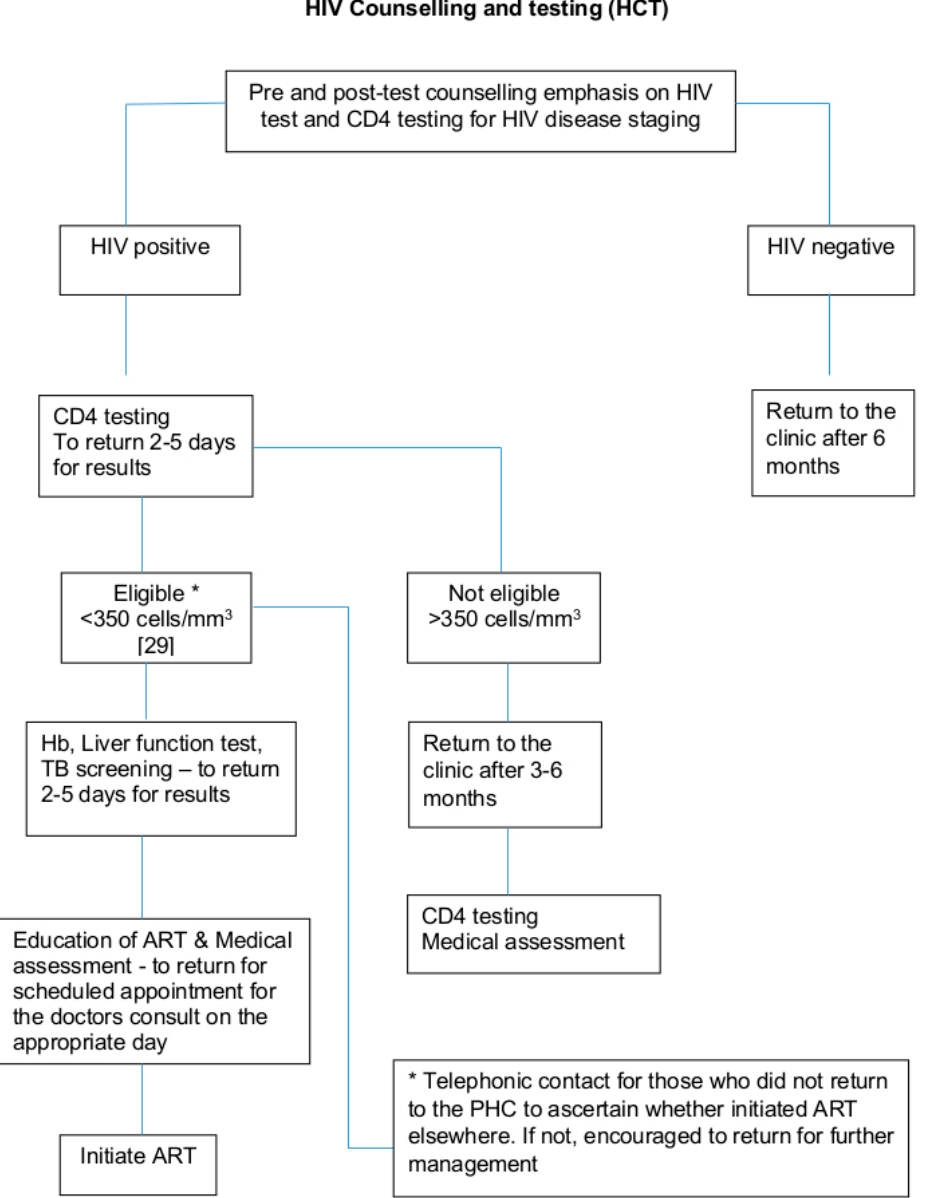
Figure 1. Schematic flow of the PHC clinic procedures with respect to HIV Counselling and Testing (HCT) (HCT) [29].